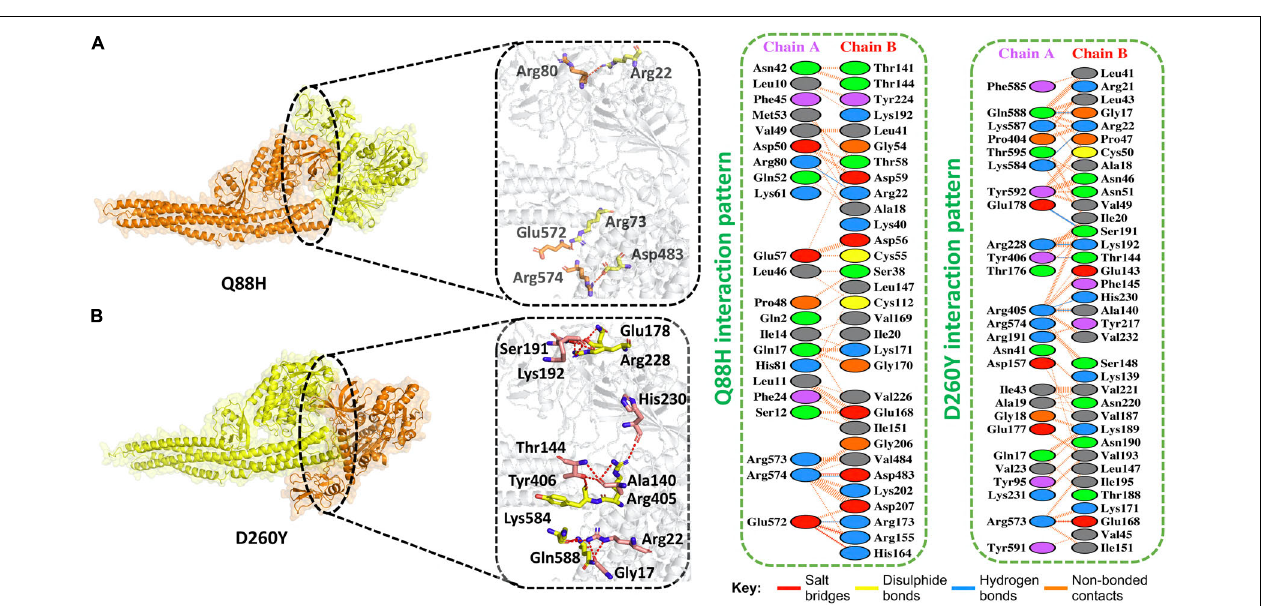
and Tyr592–Asn51 formed hydrogen bonds between TBK1 and E341D mutant ( Figure 4A